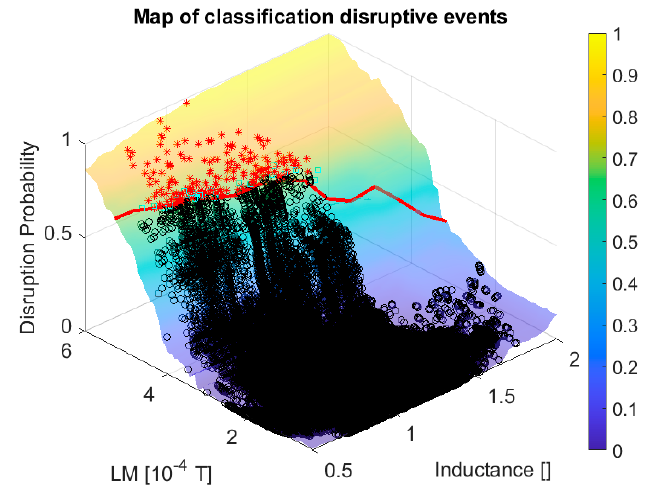
Figure 6. Plot of the safe and disruptive regions of the operational space in JET with the ILW according to the SVM. The colour code represents the posterior probability of the classifier. The black circles are all the non-disruptive shots (10 random time slices for each shot). The red asterisks are the data of the disruptive shots at the time slice when the predictor triggers the alarm. The light blue squares are the false alarms. In red is the 80% disruption probability.